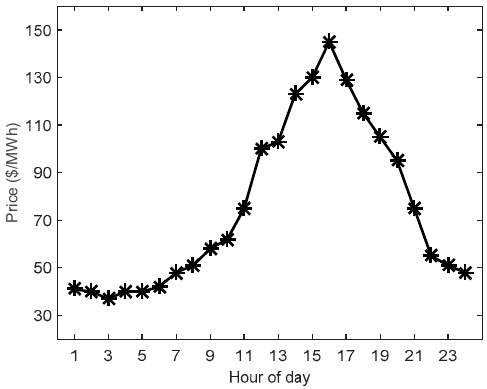
Figure 3. Day ‐ ahead wholesale market prices.